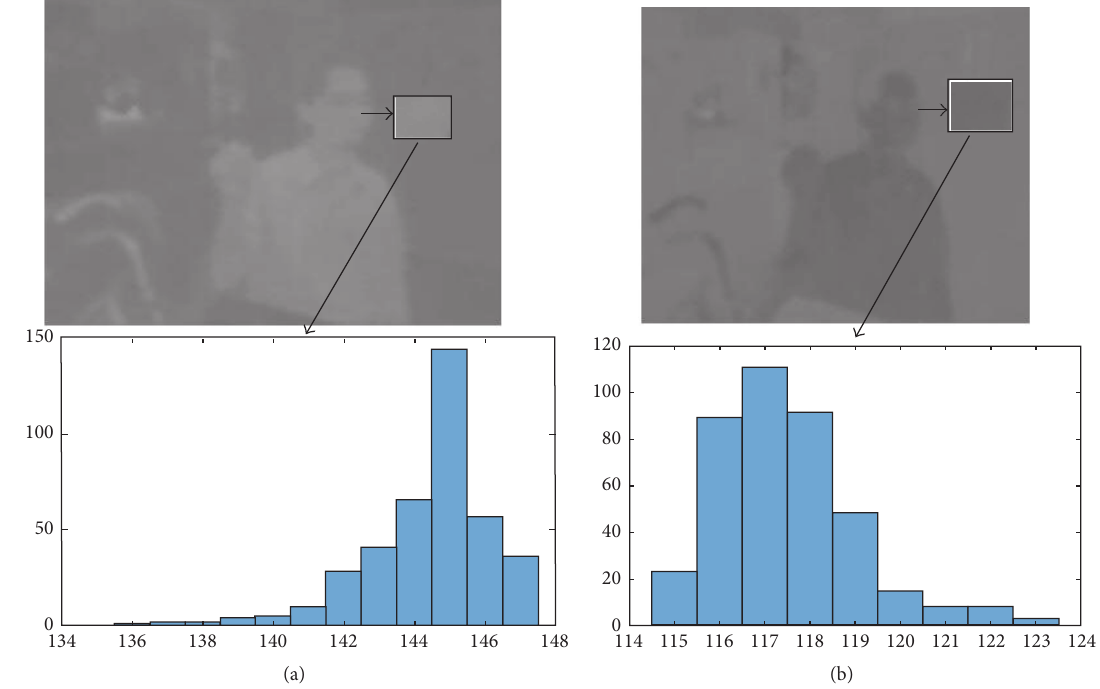
Figure 6: Sample of skin values extracted from the nose region: (a) threshold values derived from the nose region in the Cb image represented as minCb and maxCb and (b) threshold values derived from the nose region in the Cr image represented as minCr and maxCr.